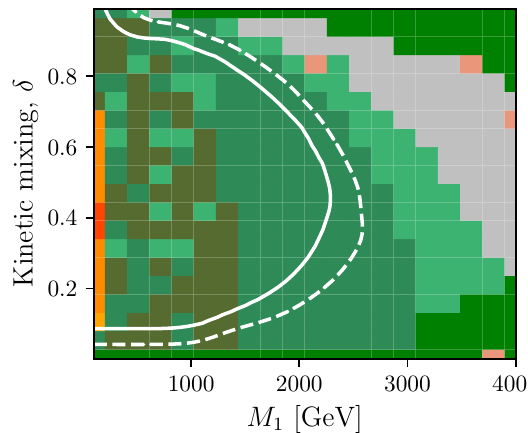
Figure 12 . The breakdown of Contur ’s most sensitive analysis pool for each scan point in the heavy Z 0 case. The solid (dashed) white line corresponds to the 95% (68%) CL exclusion on the kinetic mixing δ versus the M 1 parameter. Here m D = 2 m Z 0 and so the limits correspond to the case of Z 0 decaying to SM fermions only.